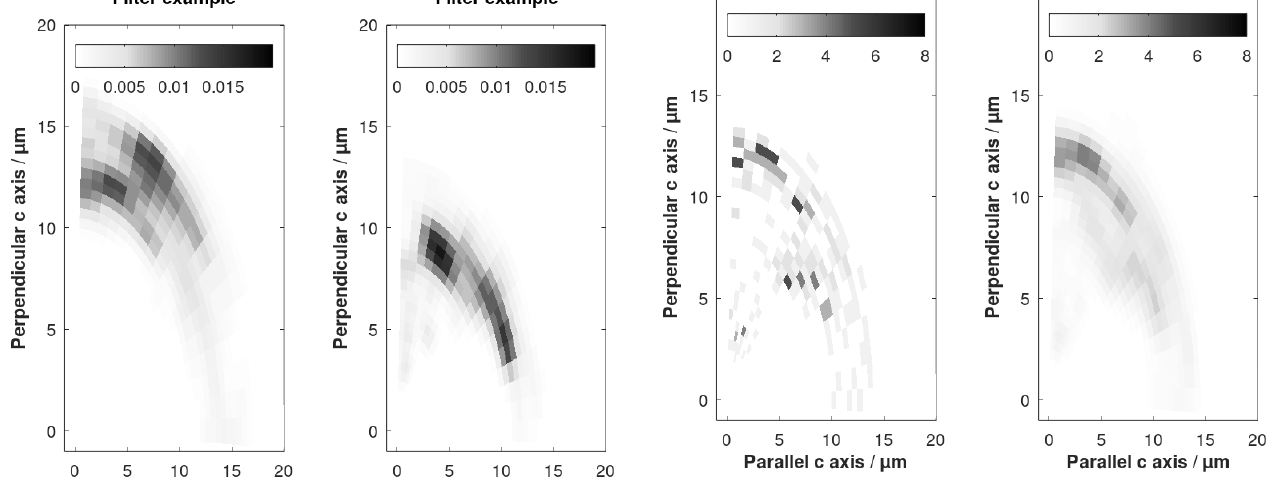
Figure E2. Examples of 3D filters used for deconvolution. They are based on heating to 275 and 320 ◦ C respectively (Barbarand et al., 2003). The greyscale range denotes frequency.